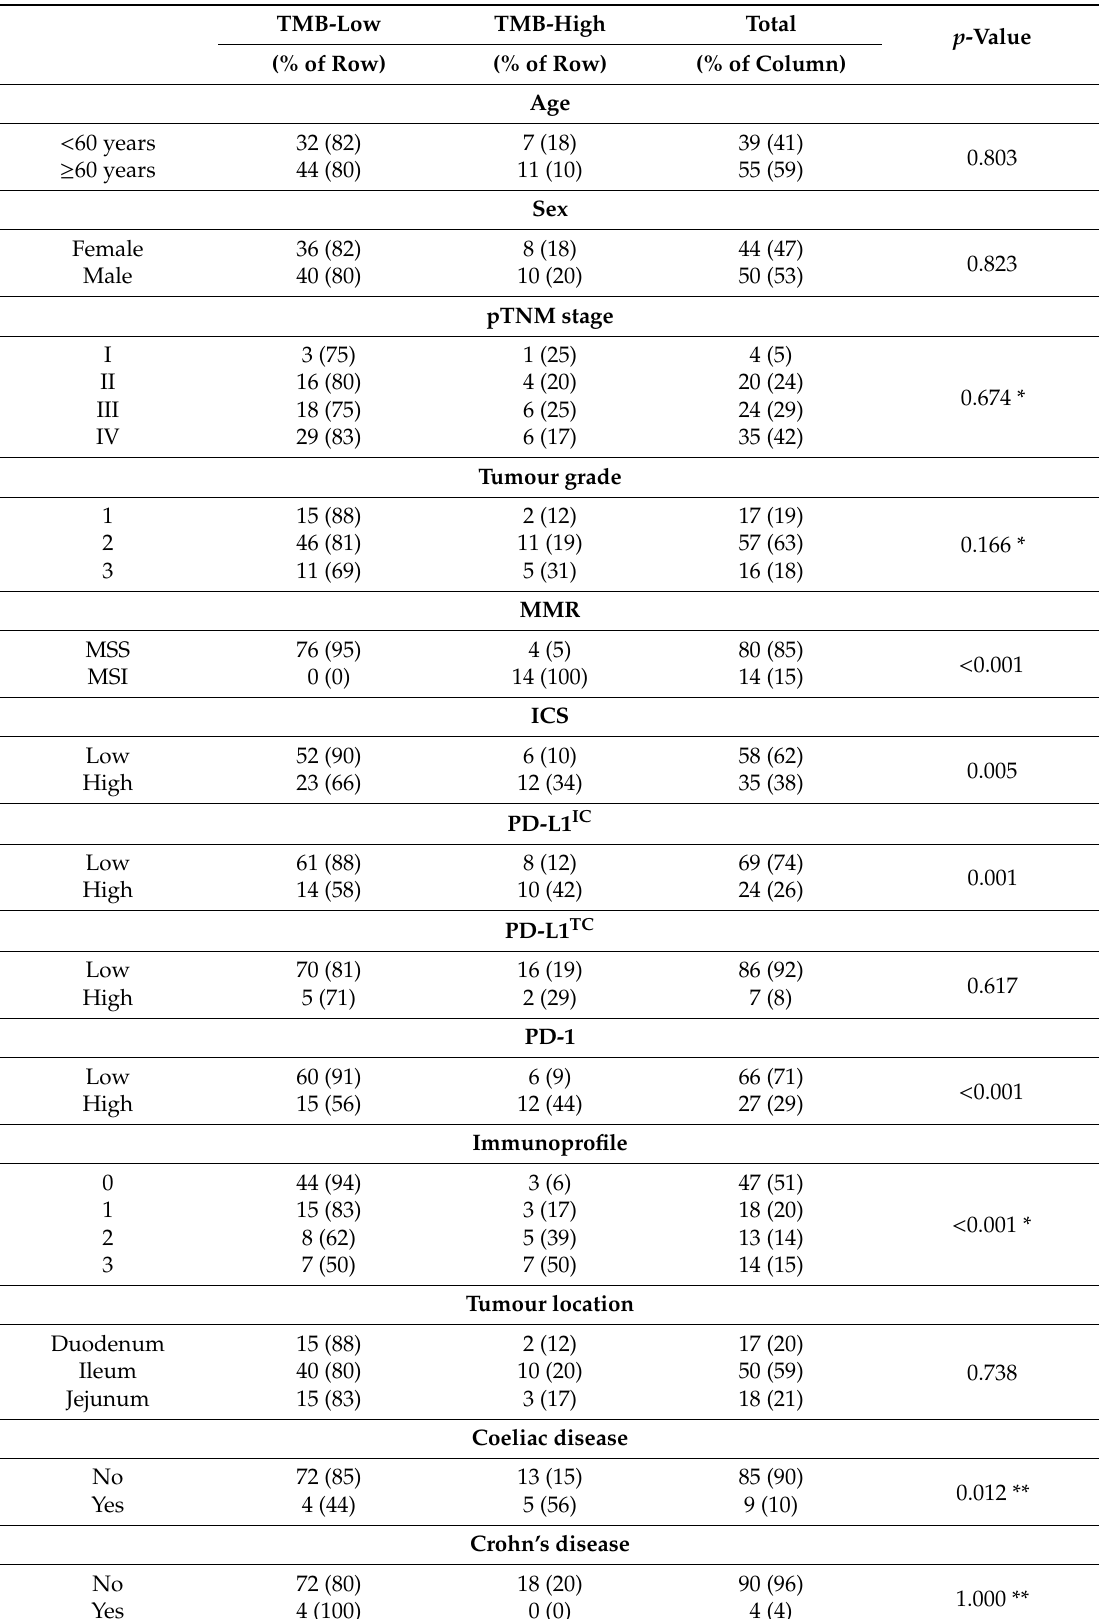
Table 3. Association of tumour mutational burden with clinicopathological